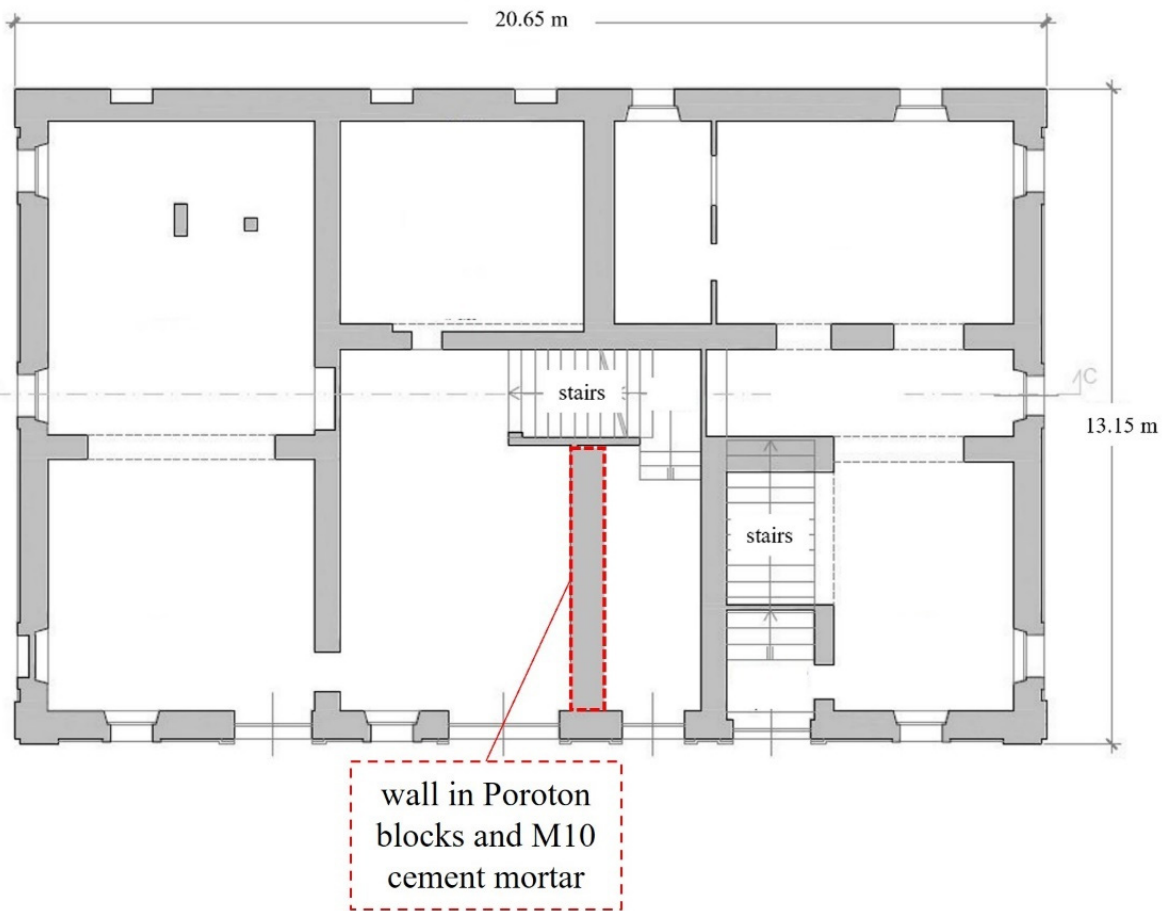
Figure 8. The new wall made in Poroton blocks and M10 cement mortar. Table 5. Mechanical properties of the masonry after the retrofitting interventions.